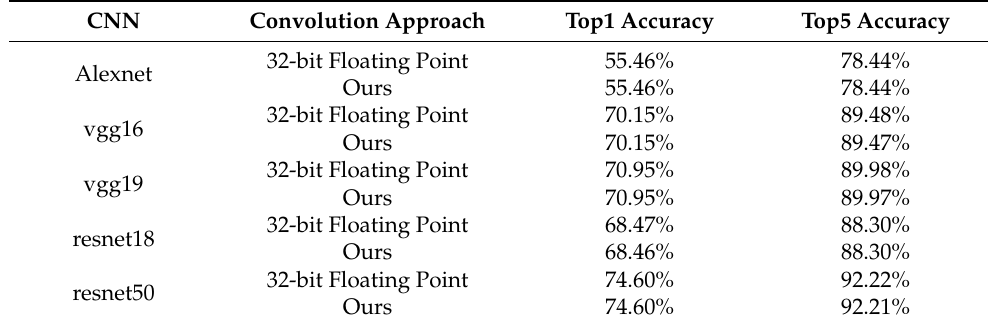
Table 1. Comparisons on the inference